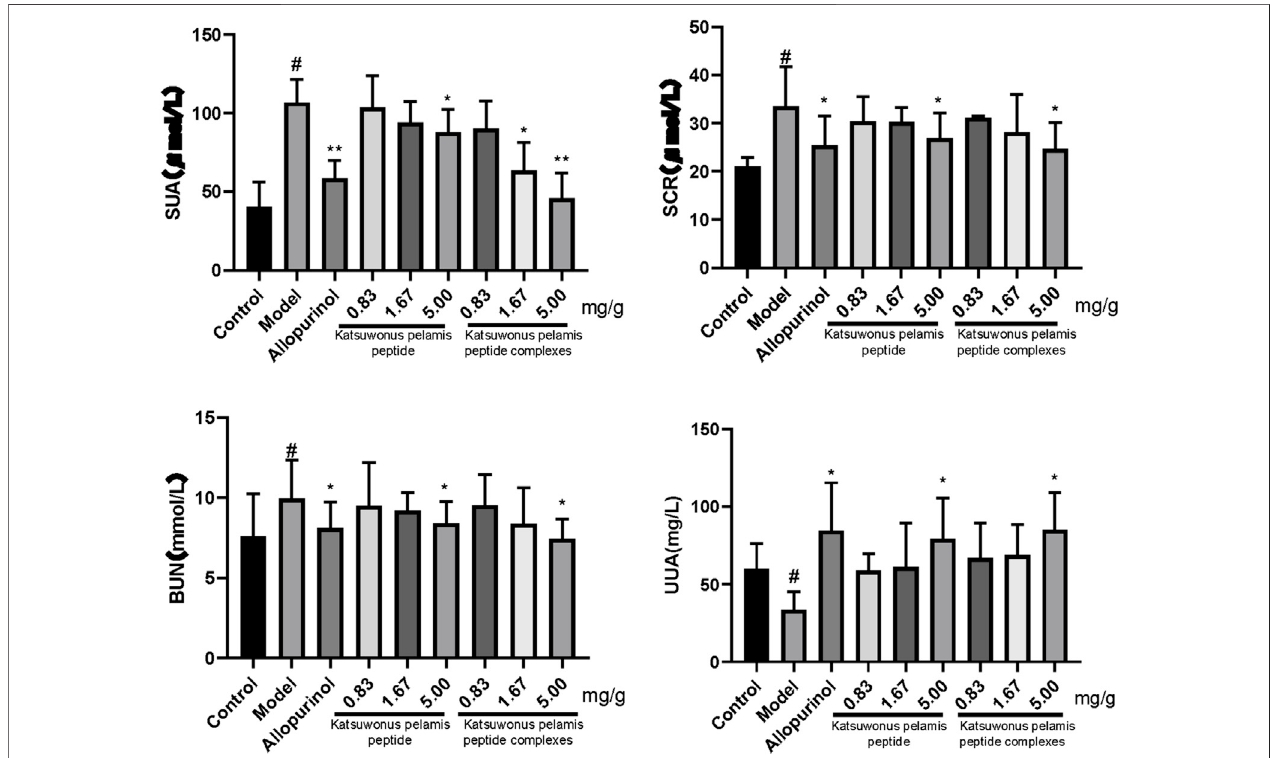
FIGURE 2 | Effect of Katsuwonus pelamis peptide and its complexes on the SUA level, SCR level, BUN level, and UUA level of potassium oxonate – induced hyperuricemic mice. # p < 0.05 compared with the control group; * p < 0.05 and ** p < 0.01 compared with the model group.